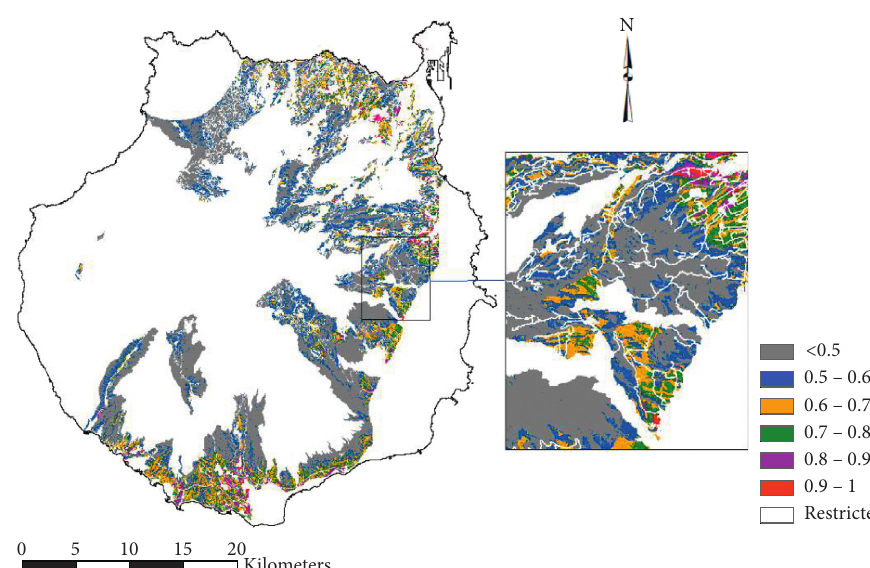
Figure 15: Solar suitability map (equal weights’